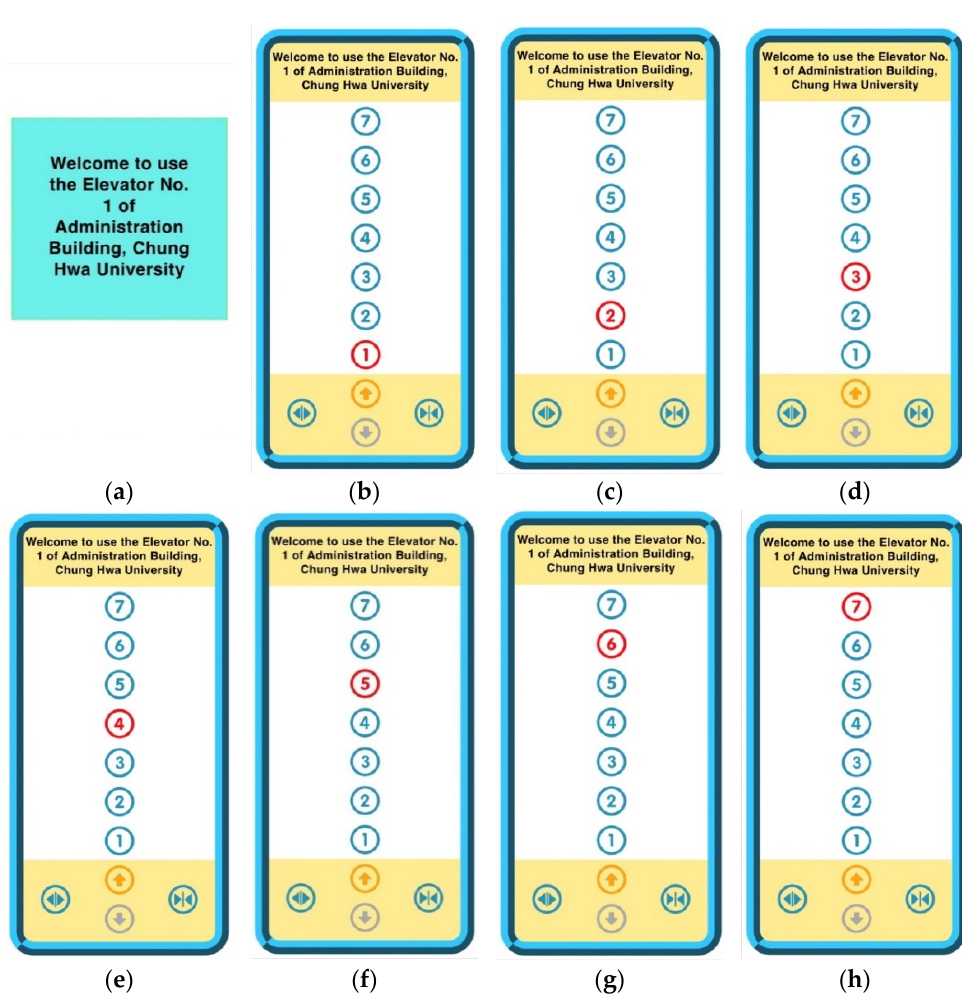
Figure A5. Images displayed on panel in the elevator hall in buildings.